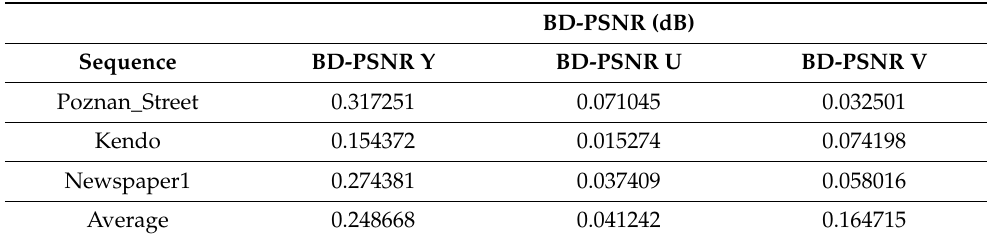
Table 3. BD-PSNR of the proposed single layered multiview video codec with respect to the anchor MV_HEVC codec.